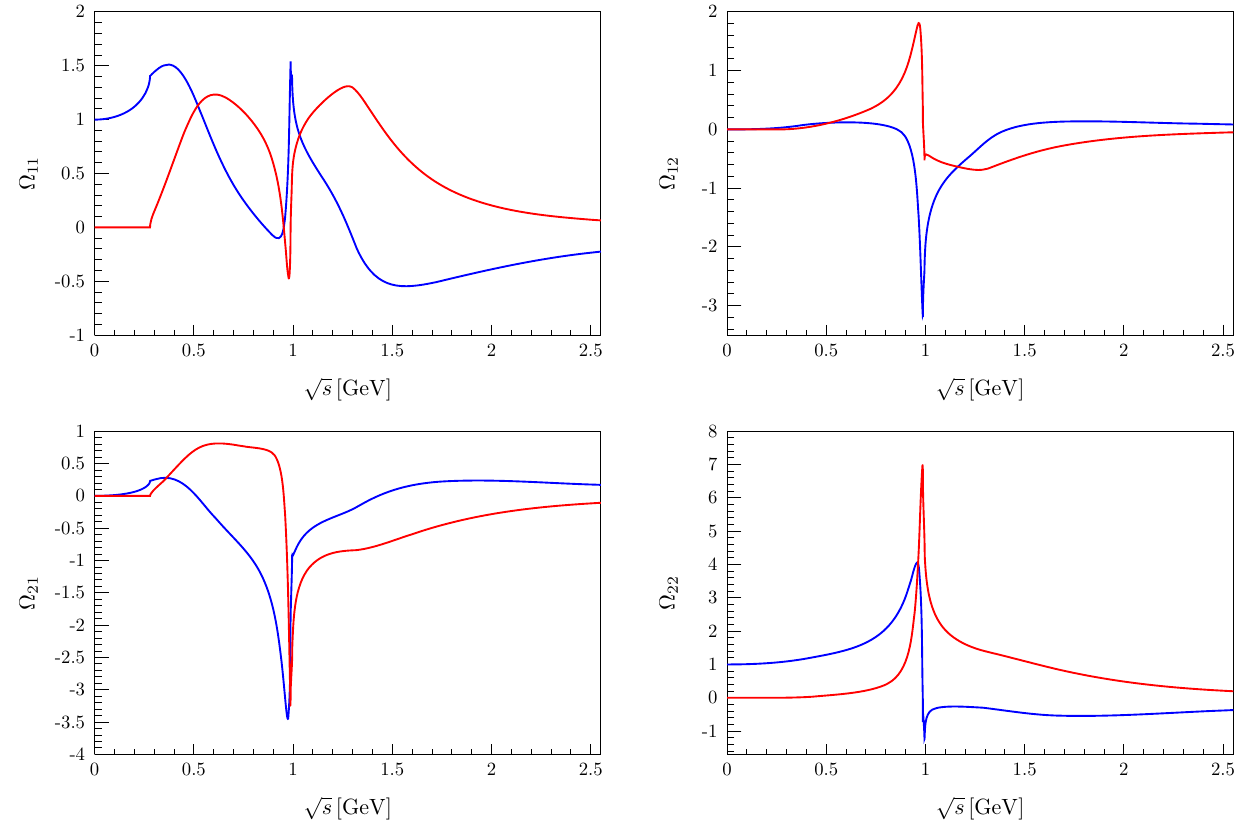
Fig. 1 Real (blue) and imaginary (red) parts of the Omnès matrix elements Ω 11 , Ω 12 , Ω 21 , and Ω 22 The discontinuities of the loop functions for the two–body channels and the 4 π channel were given in Eqs. (4) and